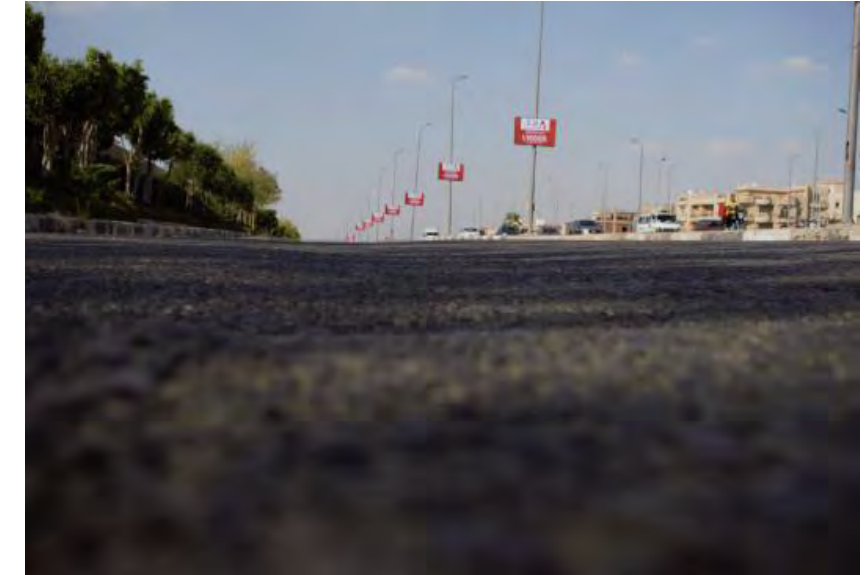
Fig. 26: Pavement damage. (Source: the authors)